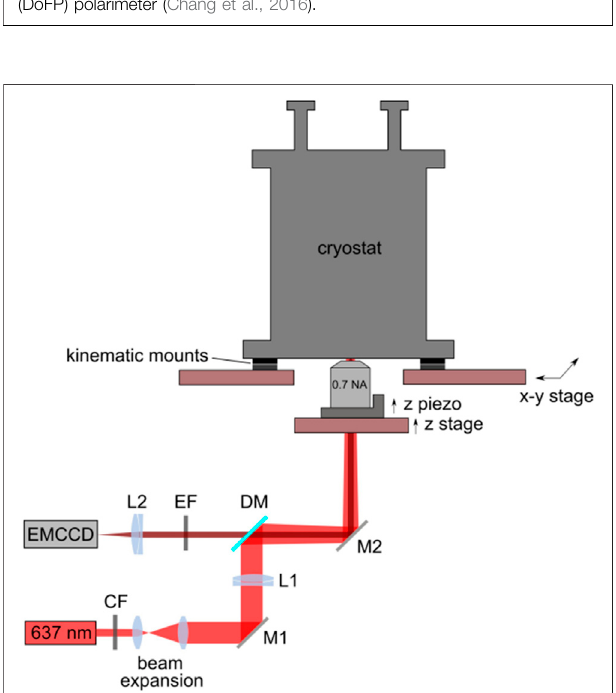
FIGURE 3 | Structure diagram of low temperature fl uorescence microscope (Li et al.,